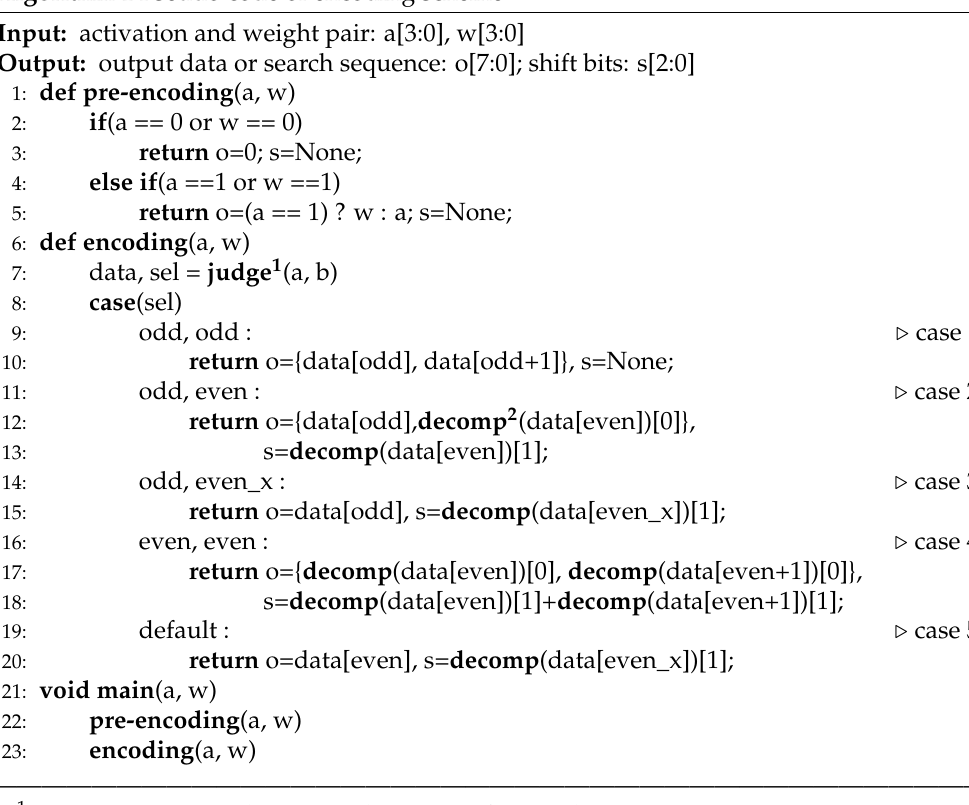
Algorithm 1 Pseudo code of encoding scheme